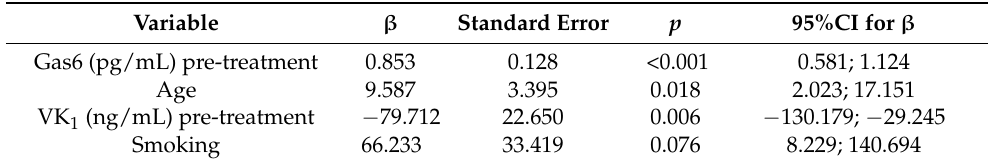
Table 4. Multivariate linear regression for Gas6 post-treatment values.